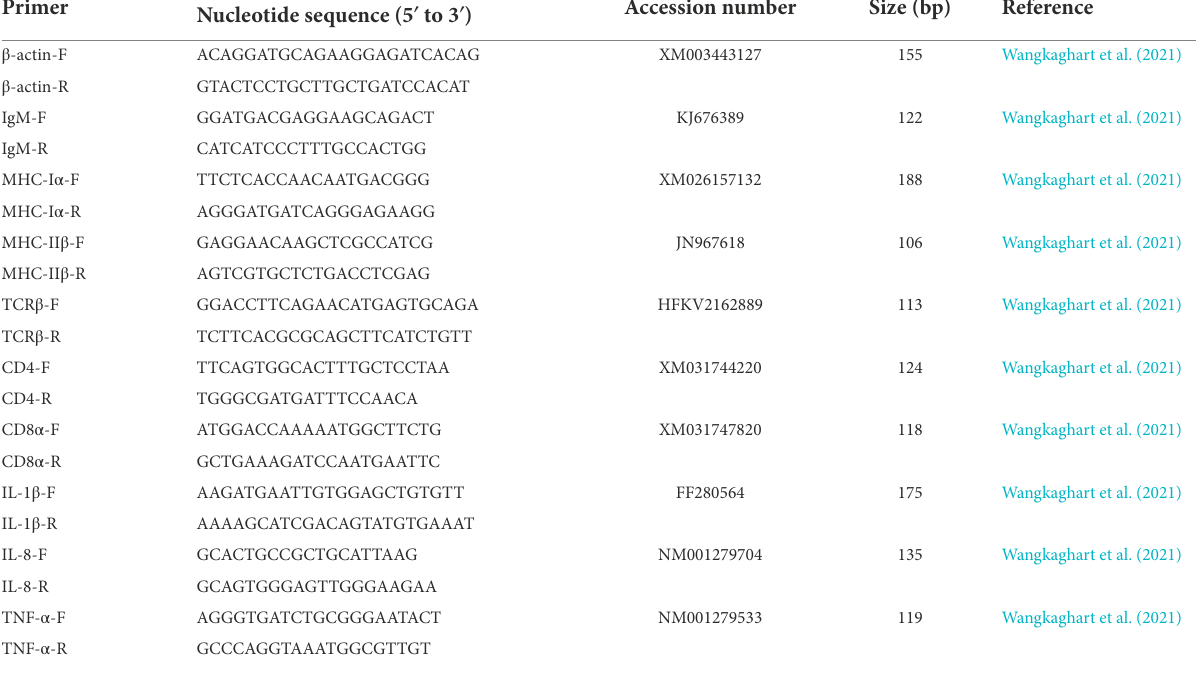
TABLE 1 Primers used for qRT-PCR to detect the expression of immune-related genes in posterior intestinal mucosa at 35 dpiv. Primer Nucleotide sequence (5 ′ to 3 ′